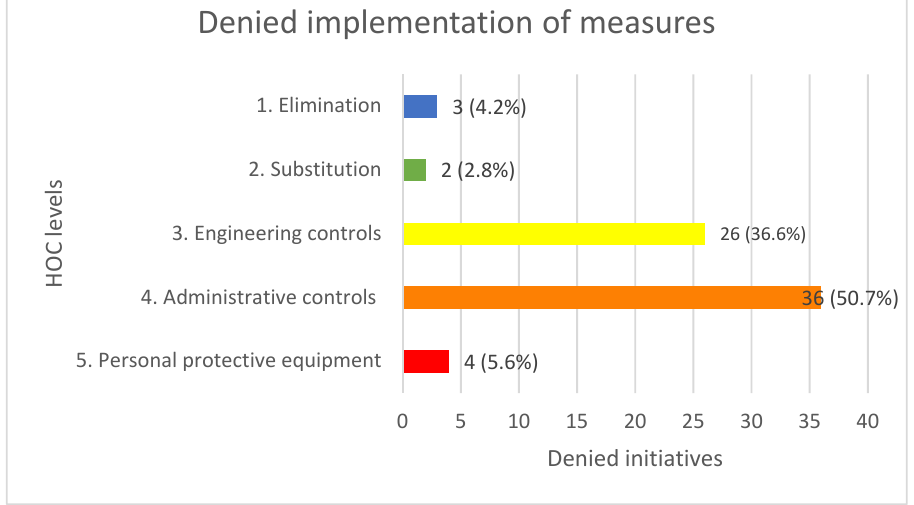
Figure 3. Number of denied initiatives and percentage of denied HOC measures.